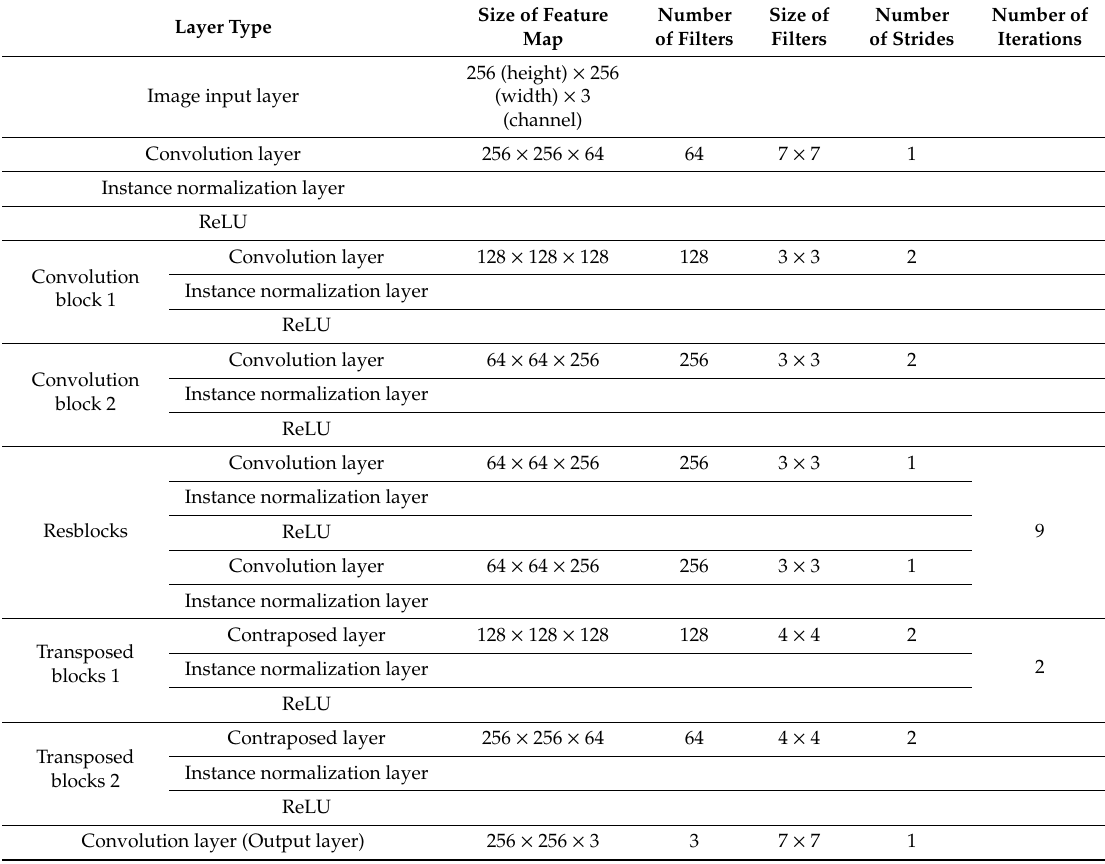
Table 2. Generator of DeblurGAN. GAN = generative adversarial network.